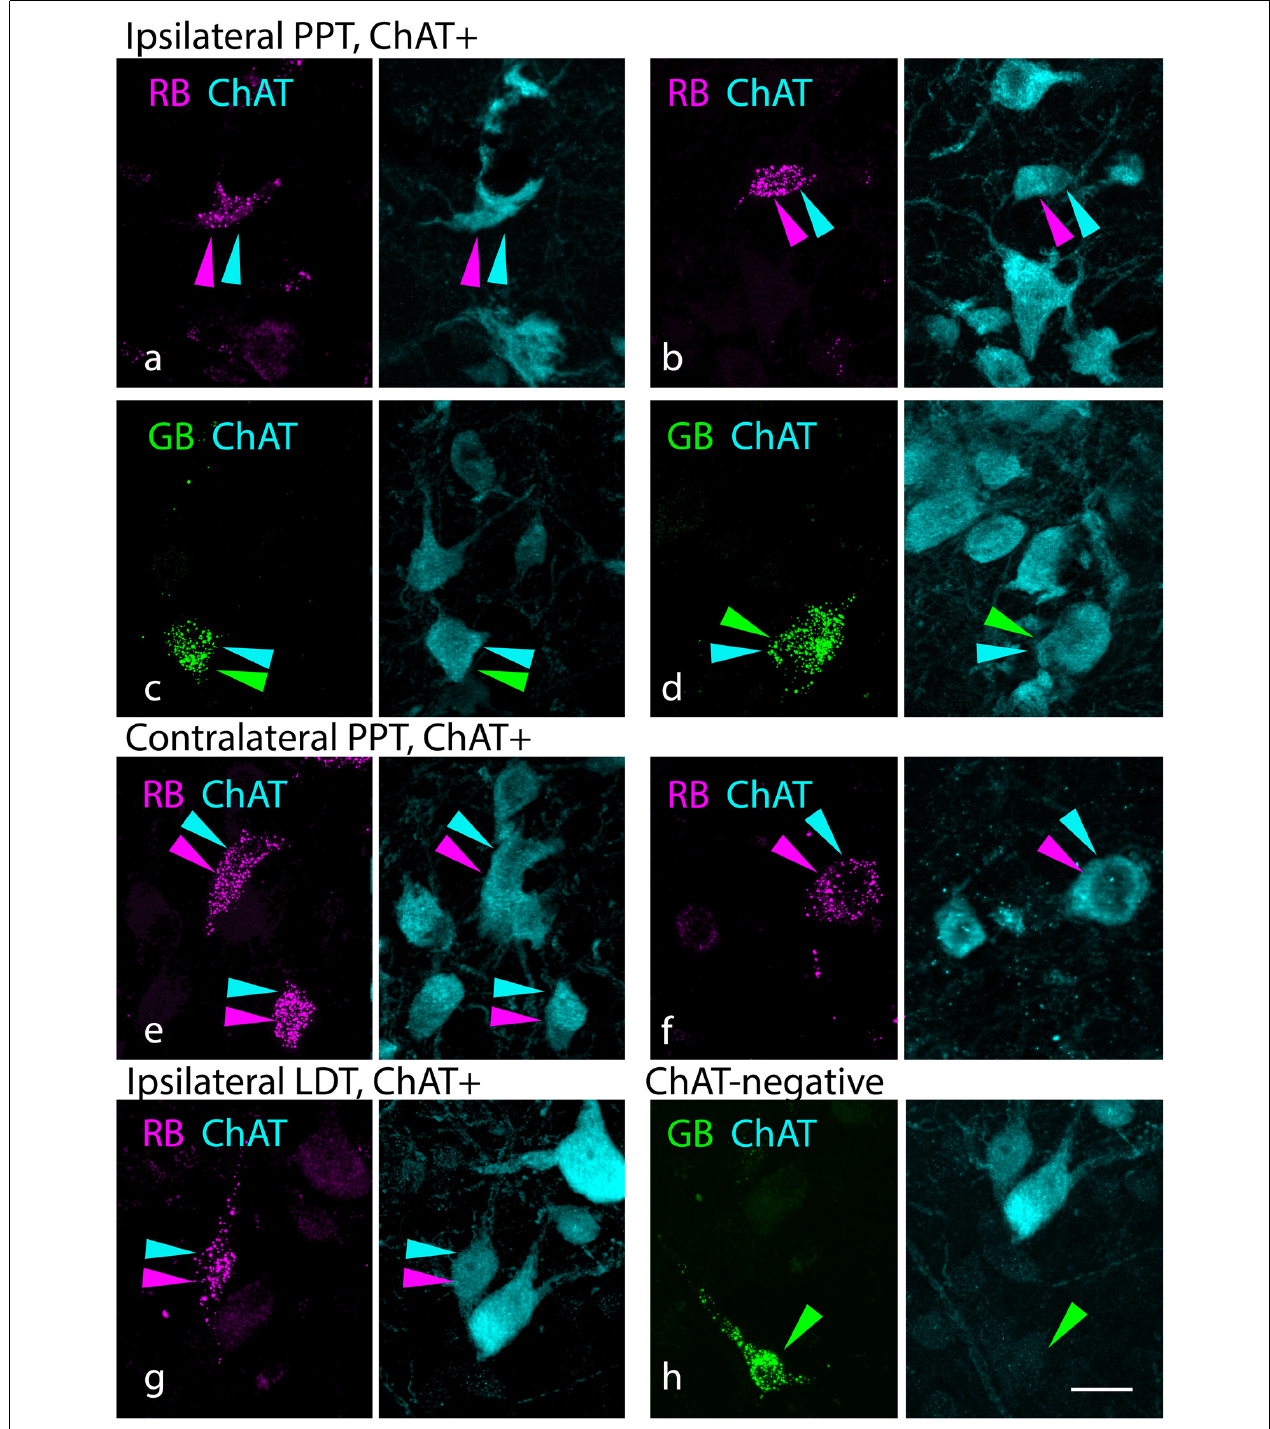
FIGURE 2 | Cholinergic and non-cholinergic PMT cells project to the SOC. (A–D) Paired photographs show tracer-labeled cells (left panel, magenta or green) in the PPT ipsilateral to the injected SOC. The right panel in each pair shows the ChAT immunostain (cyan) from the same area, demonstrating that the tracer-labeled cells were also ChAT-immunopositive. Examples were seen with both red beads [“RB”, in (A and B) ] and green beads [“GB” in (C,D) ]. (E,F) ChAT+ cells labeled with RB in the PPT contralateral to the injected SOC. (G) Example of a ChAT+ RB-labeled cell in the ipsilateral LDT. (H) Example of a ChAT-negative, GB-labeled cell in the LDT contralateral to a GB injection. Panels (A) and (F) are from deposit G18-3033 RB (lateral SOC); the remaining panels are from deposit G18-2012 (medial SOC deposits). Scale bar = 20 µ m. Abbreviations: LDT, laterodorsal tegmental nucleus; PMT, pontomesencephalic tegmentum.